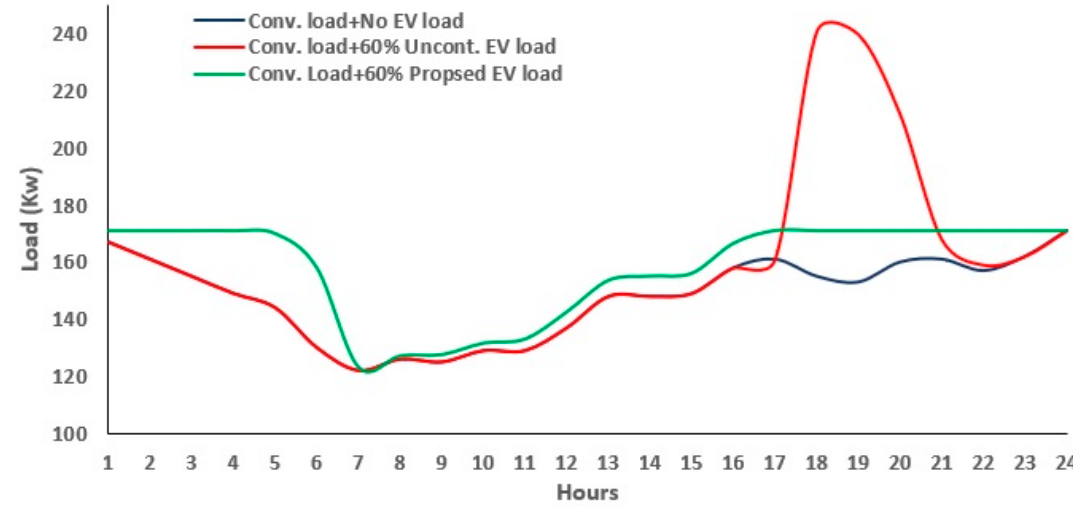
Figure 19. Load profiles of Transformer 740/feeder 1 in summer at 60% EVC with/without response to the critical hours.